Question: In one sentence, what is this figure communicating?
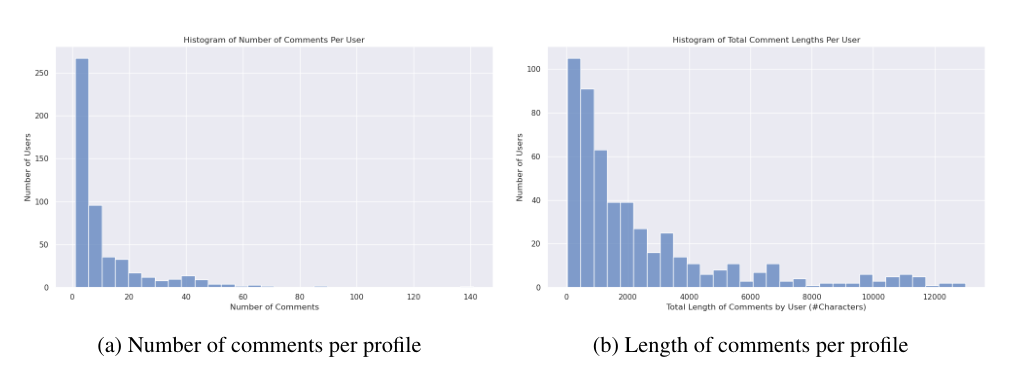
Answer: Visualization of the hardness and certainty distributions over all attributes in the Person- alReddit dataset.